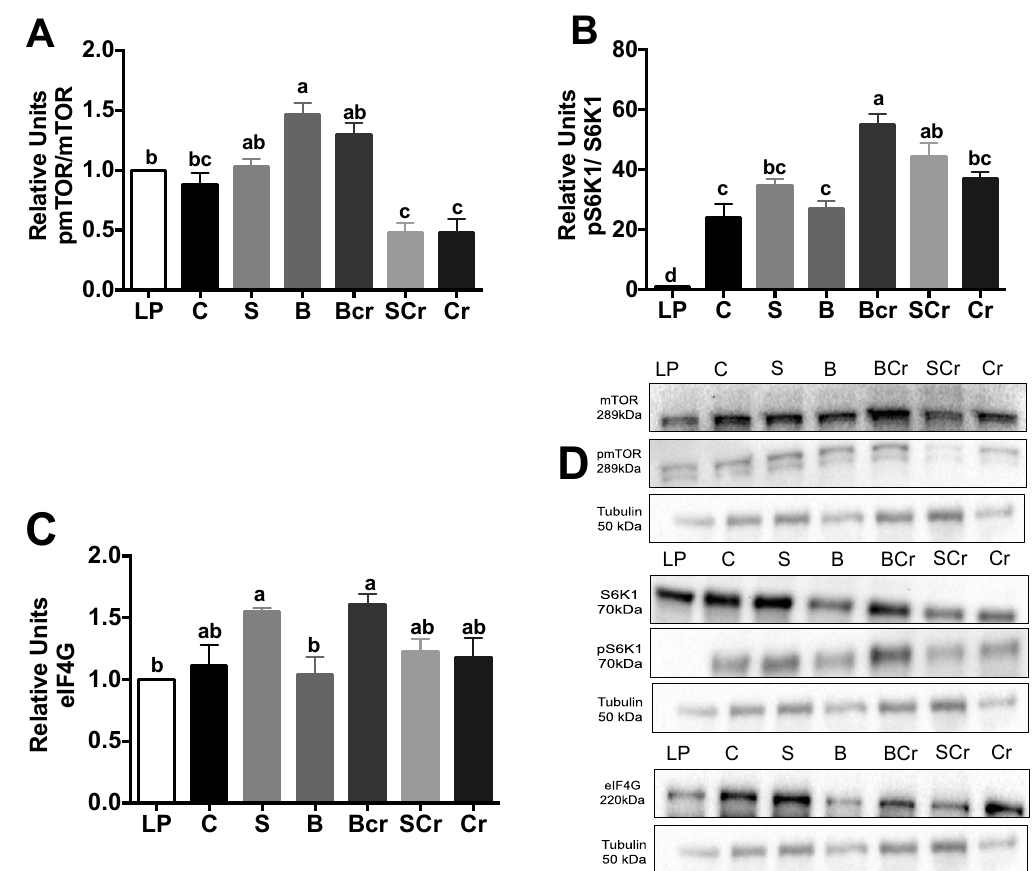
Figure 10. Western blot analysis and quantification of the: ( A ) phosphorylation of mTORC1; ( B ) phosphorylation of S6K1; ( C ) protein abundance of muscle eIF4G; and ( D ) representative Western blot of rats fed different types of protein for seven days after a protein restricted period. Values are means ± SEM, n = 3. Different letter superscript indicates significant differences among groups, p < 0.05, a> b > c.